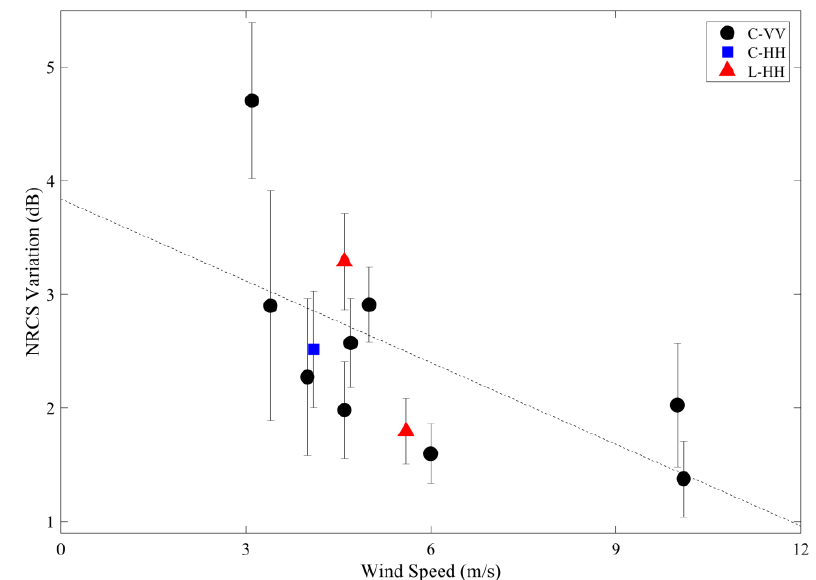
Figure 10. Relationship between the wind speed (m/s) and the variation in NRCS (dB).